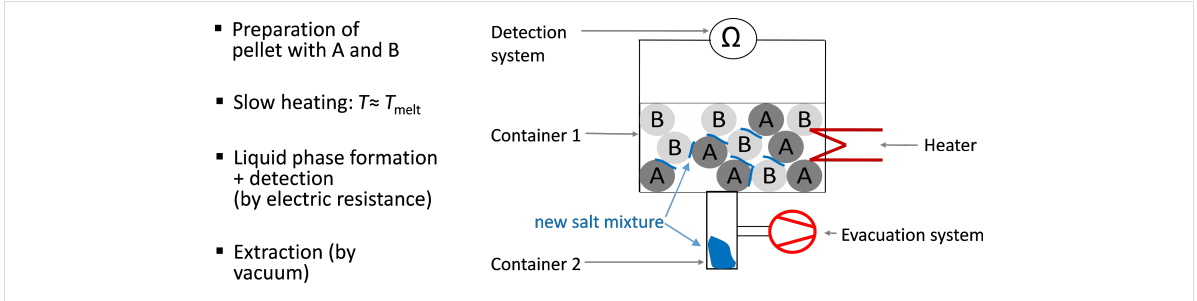
A salt mixture of arbitrary non eutectic composition (for example X non-eu ) is slowly heated above the solidus tempera- ture T solidus . A measurement system detects the liquid phase above T solidus . The scheme of the phase diagram in Figure 8 shows that the molten salt composition is mainly the eutectic composition X eu at the temperature T max . Following the detec- tion of the liquid phase it is extracted via a filter and a valve. To find the composition of the salt system with reduced melting temperature, the extracted phase can be analyzed in terms of composition by analytical standard